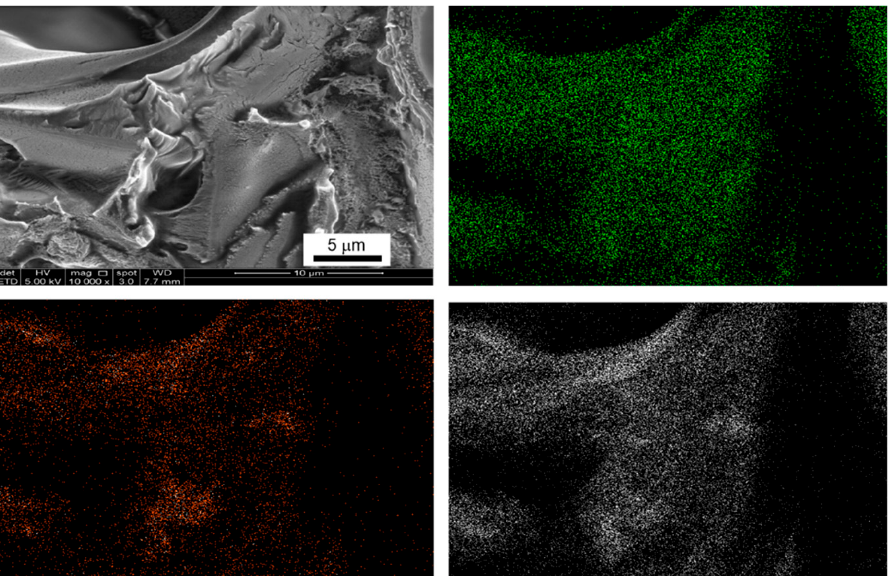
Figure 11. SEM images and EDX mapping of HB: PMMA (0.5:1) (green is referred to boron, orange to nitrogen and white to oxygen).